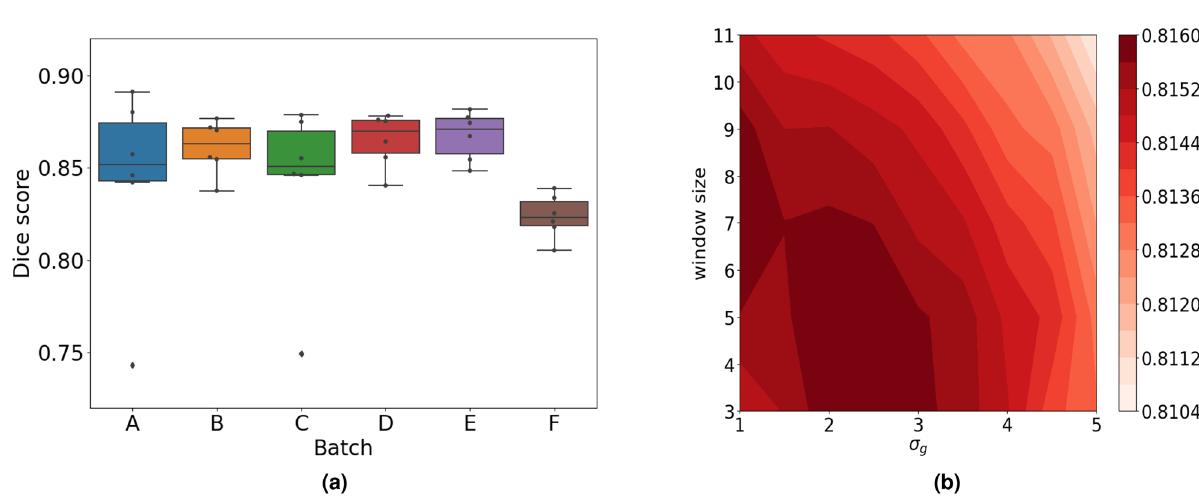
Figure 8. ( a ) Obtained Dice scores per batches with the following values for parameters: windows size for median filter equal to 5 and σ g = 2.5 ( b ) Averaged Dice scores during grid search for parameters σ g and windows size for median